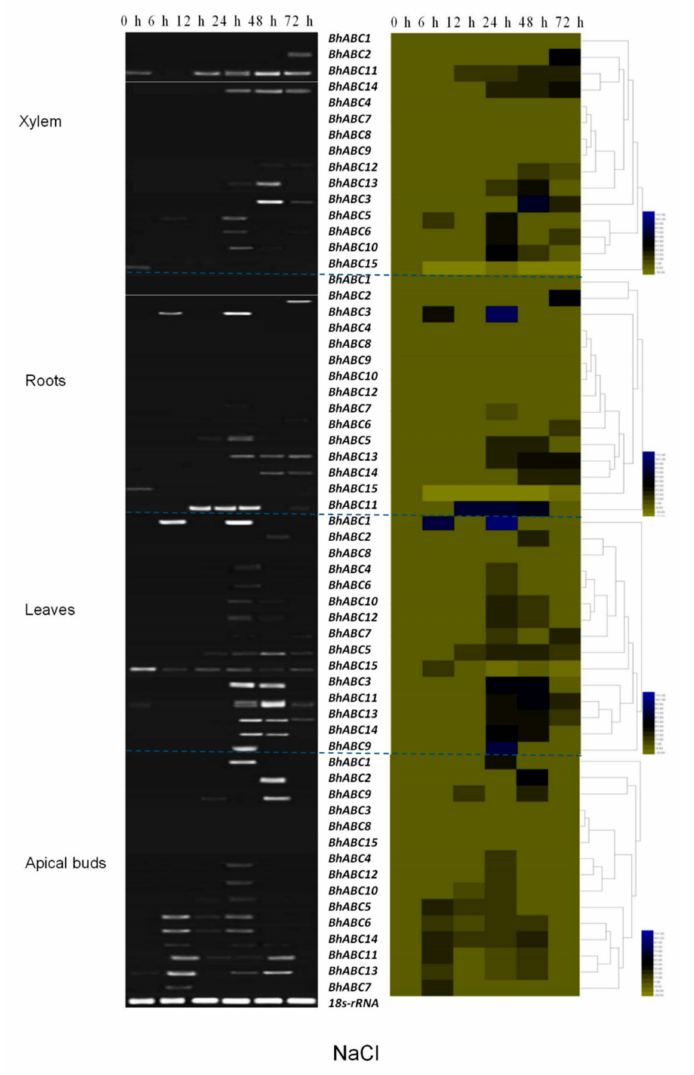
Figure 10. Expression patterns of BhABC genes in xylem, roots, leaves, and apical buds after NaCl treatment. Heat map showing responses of BhABC genes to NaCl (right); semi-quantitative RT-PCR analysis with 18s RNA internal reference